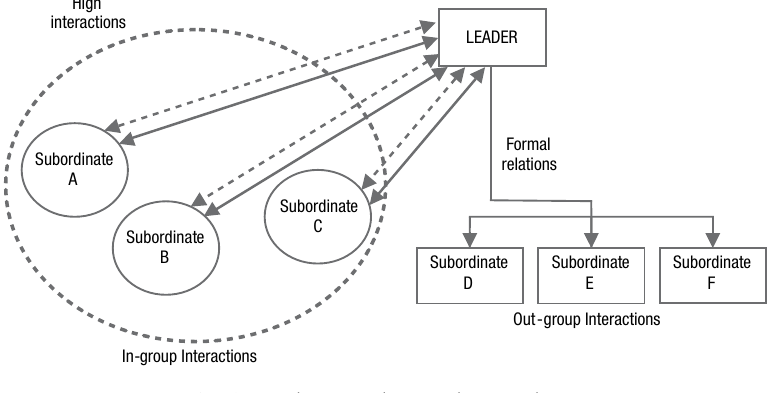
Fig. 1. Leader–Member Exchange